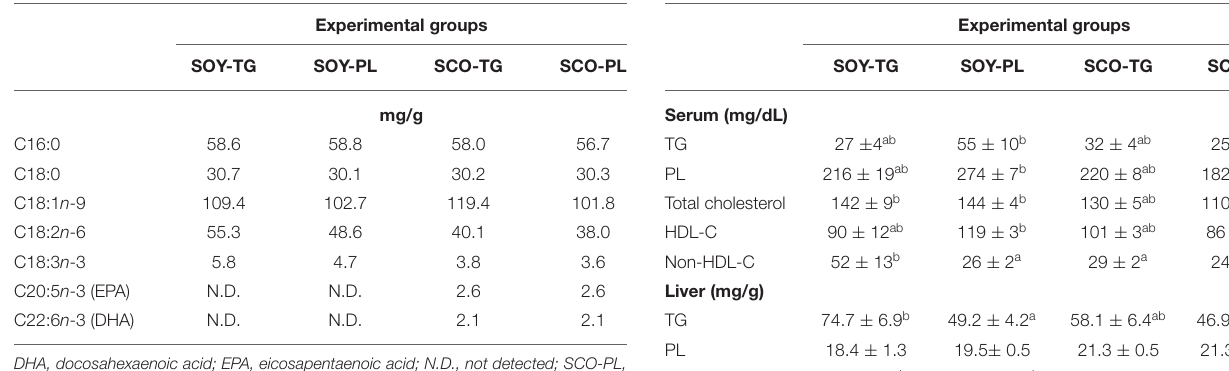
Experimental groups